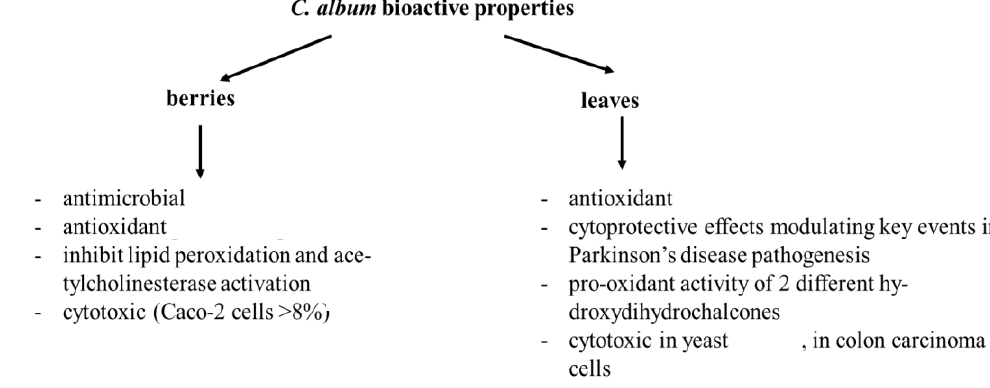
Figure 3. Summary of bioactive properties found in the literature for C. album berries, leaves, or their